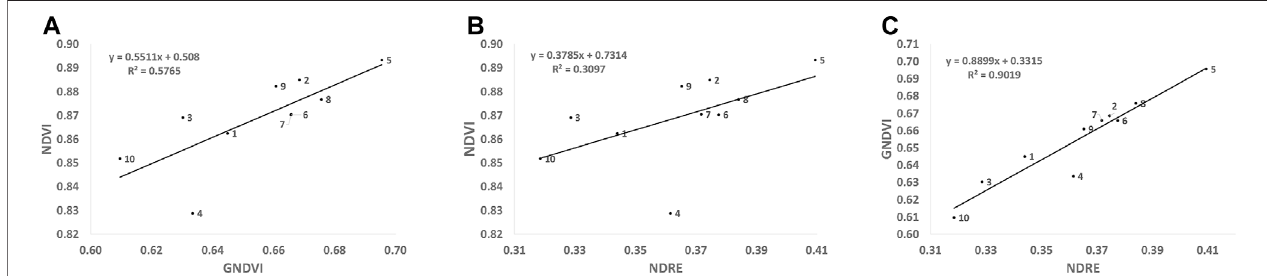
FIGURE7| Relationship betweentheVIsforthestudyplots inQuintadoCanal: (A) GNDVIand NDVI, (B) NDREandNDVI,and (C) NDREand GNDVI.Dataarefor July 9, 2020, from UAS images. The relations obtained by linear regression and the corresponding coef fi cients of determination are given.